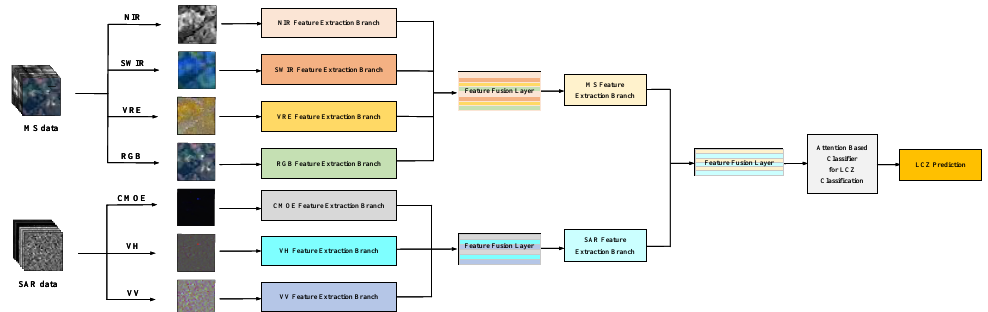
Figure 2. The overall flowchart of the proposed method